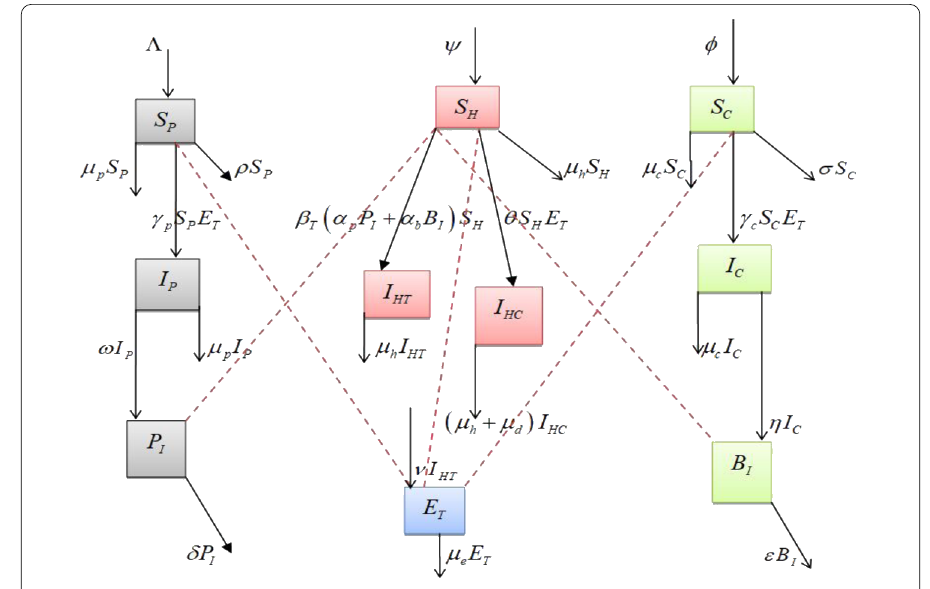
Figure 1 The model flow diagram